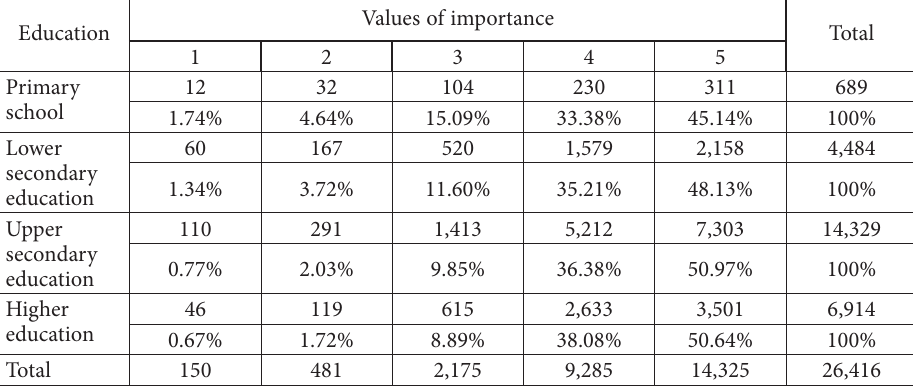
Table 12. Relative frequency for motivational factor job security from the point of view of